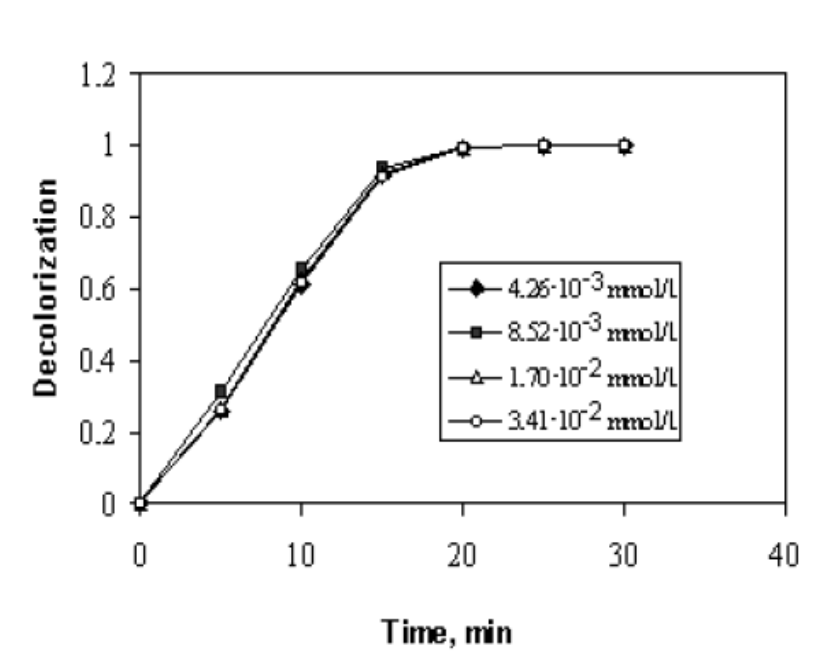
Fig. 13 Effect of Ni 2+ ions on AOP in acidic medium. Initial conditions: C dye =50 mg/L, [H 2 O 2 ]= 17.318 mM.